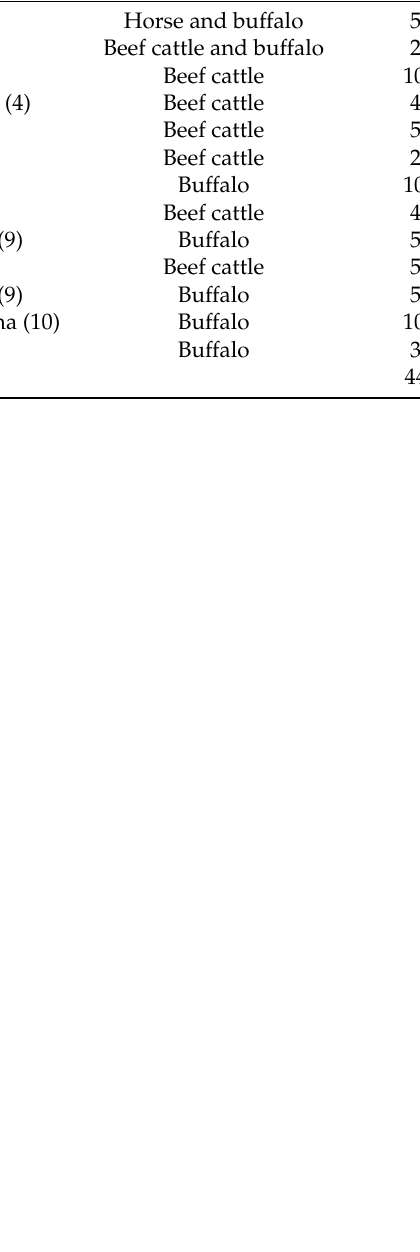
Figure 3. Map of Tabanus collection sites in Thailand: Phitsanulok (1), Nakhon Pathom (2), Chainat (3), Prachuap Khiri Khan (4), Chumphon (5), Chiang Mai (6), Uthai Thani (7), Singburi (8), Nakhon Ratchasima (9, 10), and Sa Kaeo (11). Table 1. Collection sites and number (N) of wing images of Tabanus spp. used for the landmark-based geometric morpho- metric analysis. Figures into brackets refer to sites in Figure 3.